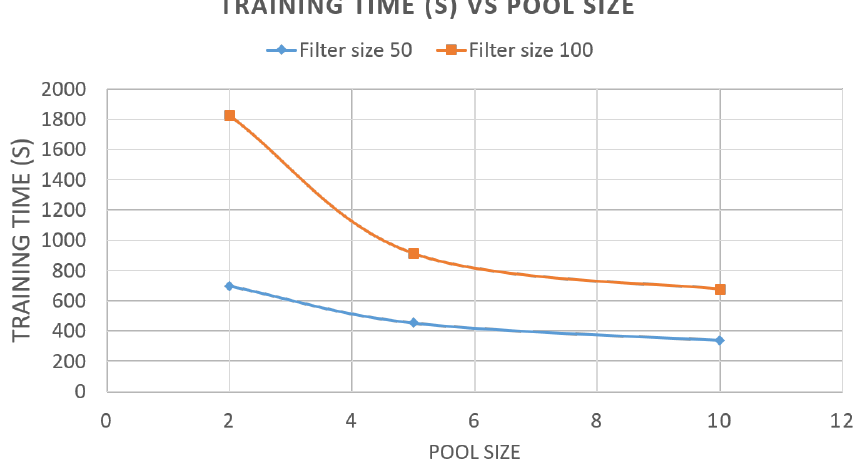
Figure 15. Comparison between the total training time and the pool size for the CNN when fixing the filter size to 50 (blue) and 100 (orange).